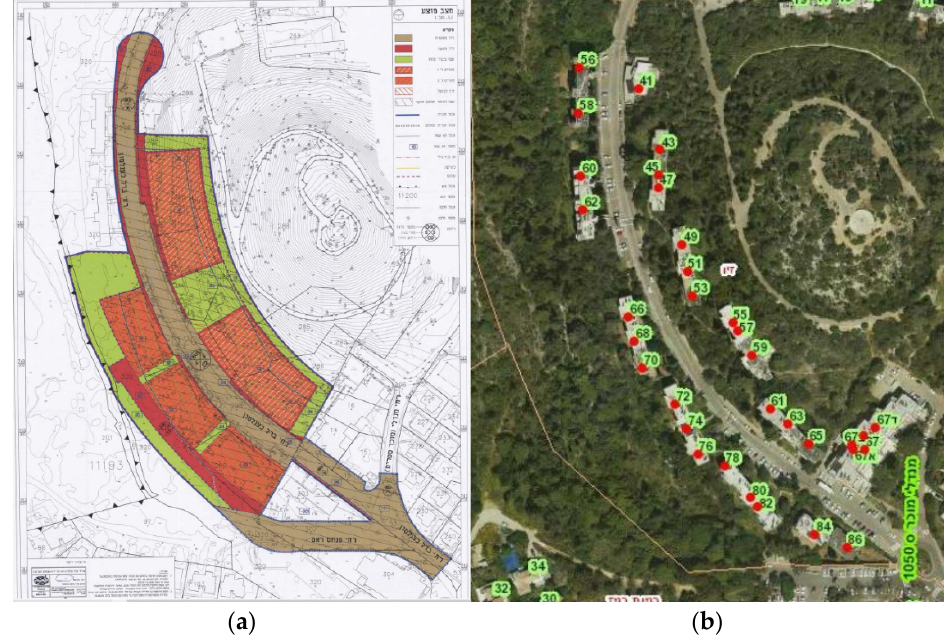
Figure 2. ( a ) Berl-Katzenelson Site, the approved plan, 2006. Reduction of the public spaces between the buildings (orange: residential housing; green: open areas; red: new road). The design: Uzi Gordon Architects. Source: the Israeli “Available Planning” website (The Planning Administration, Ministry of Interior) archive; ( b ) Berl-Katzenelson Site, existing situation before the urban renewal. Source: the city of Haifa website, 2015.